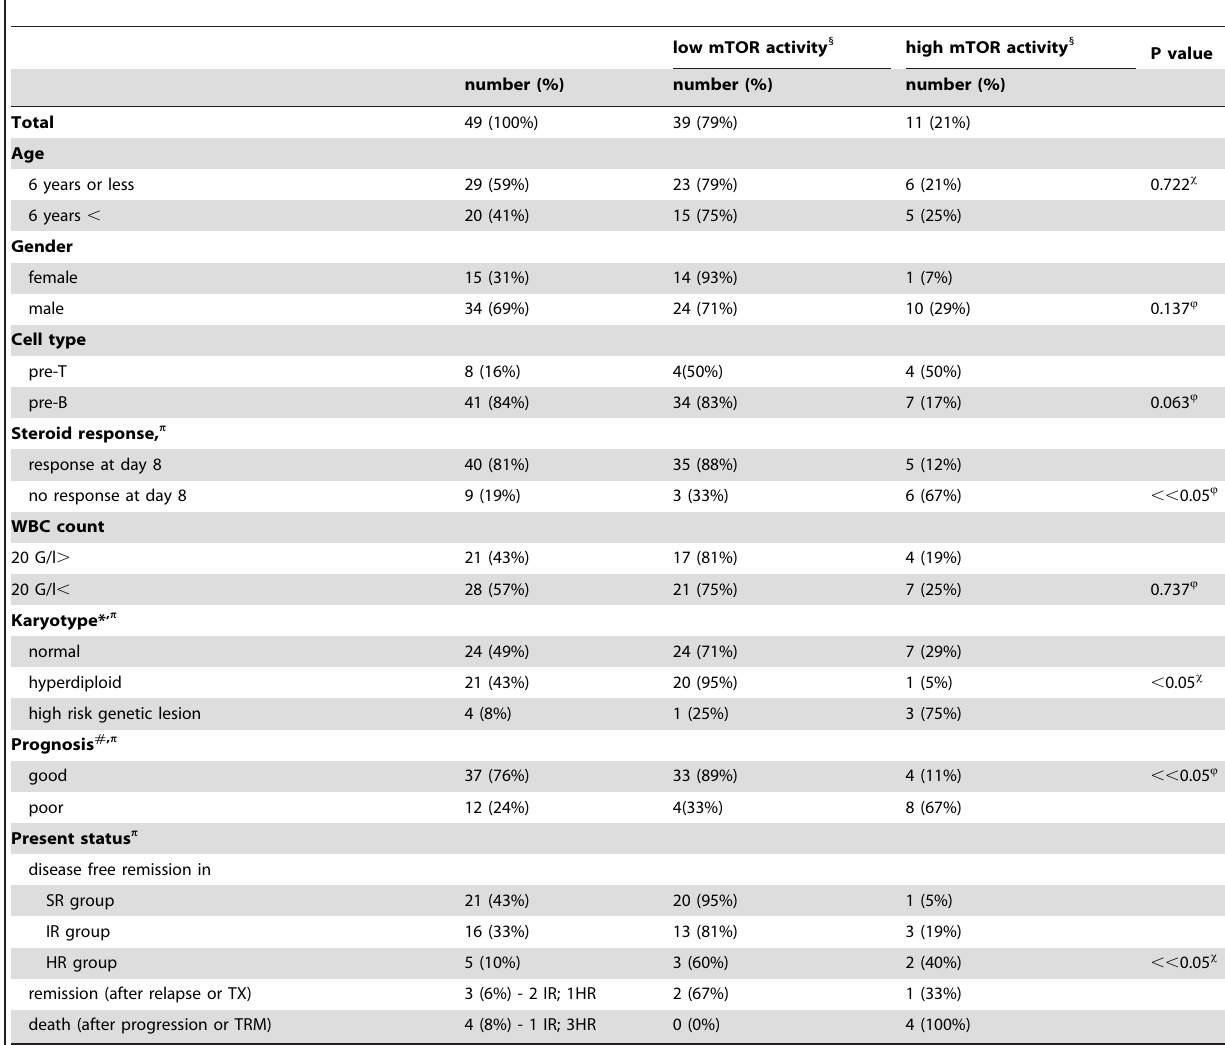
Table 1. Summary of clinical data and mTOR activity related p-4EBP1 in 49 primary ALL